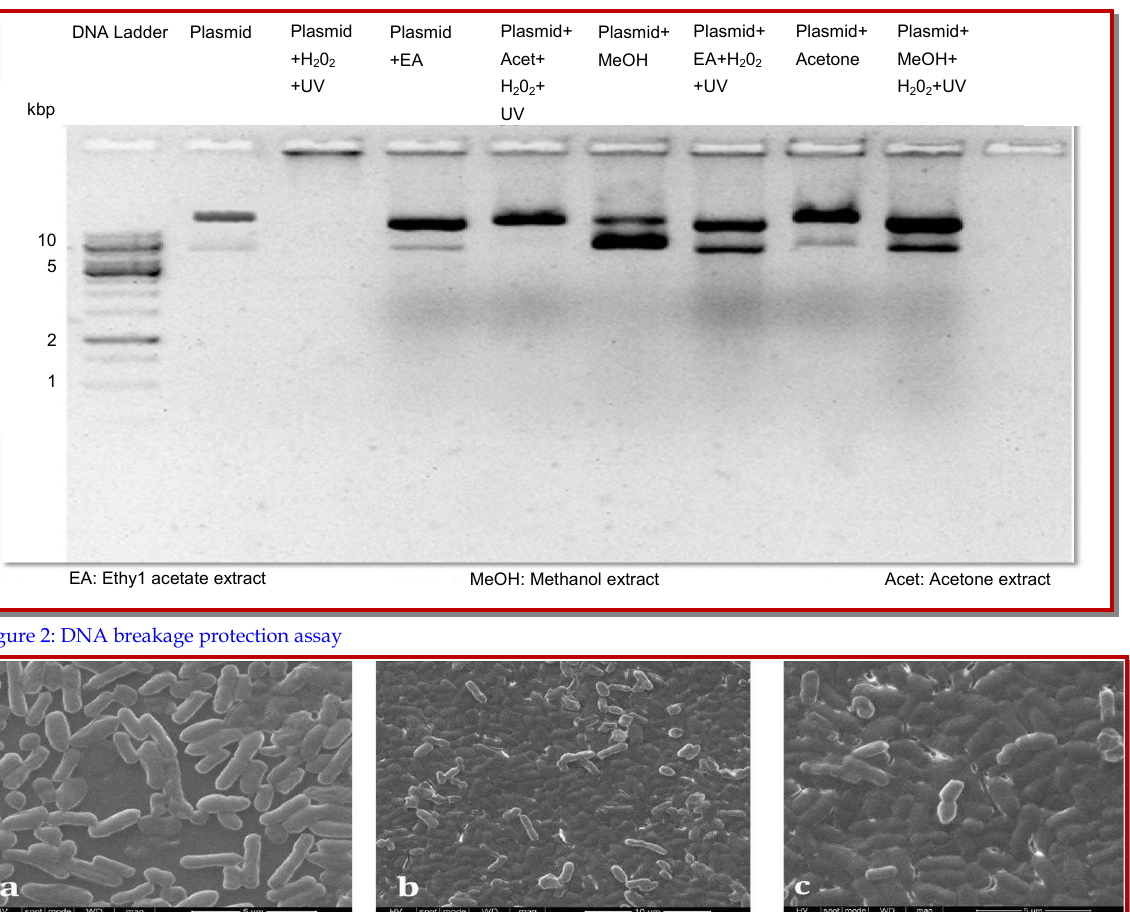
Figure 3: SEM images of E. coli